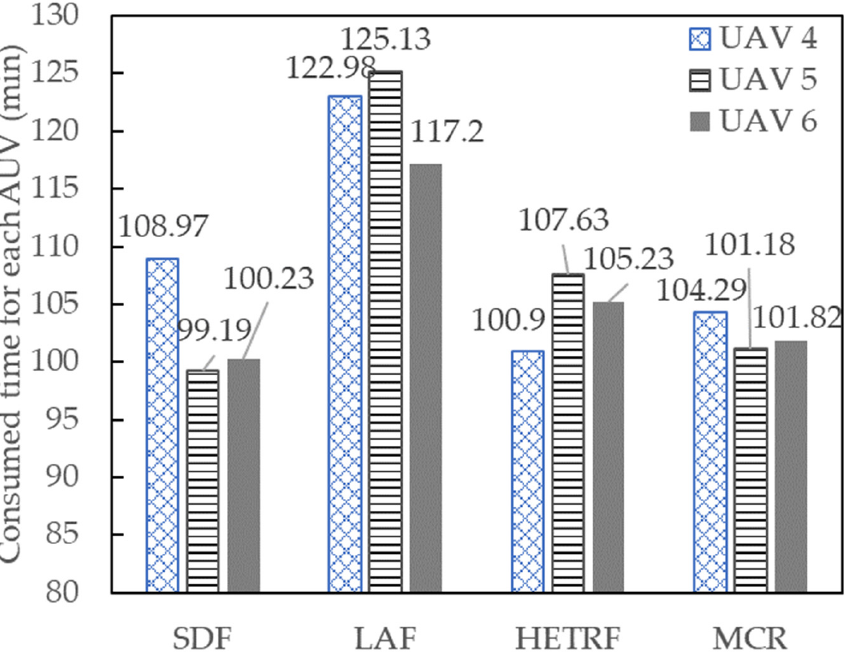
Figure 9. The consumed time of heterogeneous UAVs for four algorithms. In general, when using the MCR algorithm, the maximum time consumption is the shortest. The time cost for three UAVs has the smallest overall variance and the minimum time consumption differences of the three drones, proving the assigned tasks are well bal- anced. It shows that the MCR allocation algorithm has better performance for both homo- geneous and heterogeneous UAVs.